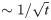
A, Test loss as a function of number of training epochs of the CNN for different simulation lengths. B, Minimal loss (that is, smallest loss in panel A) as a function of simulation length. A function with ∼1/t shape was fitted to the data to illustrate that the scaling is explained by limited amount of data and that the error decreases as more data is used. The R2 score was 0.994.